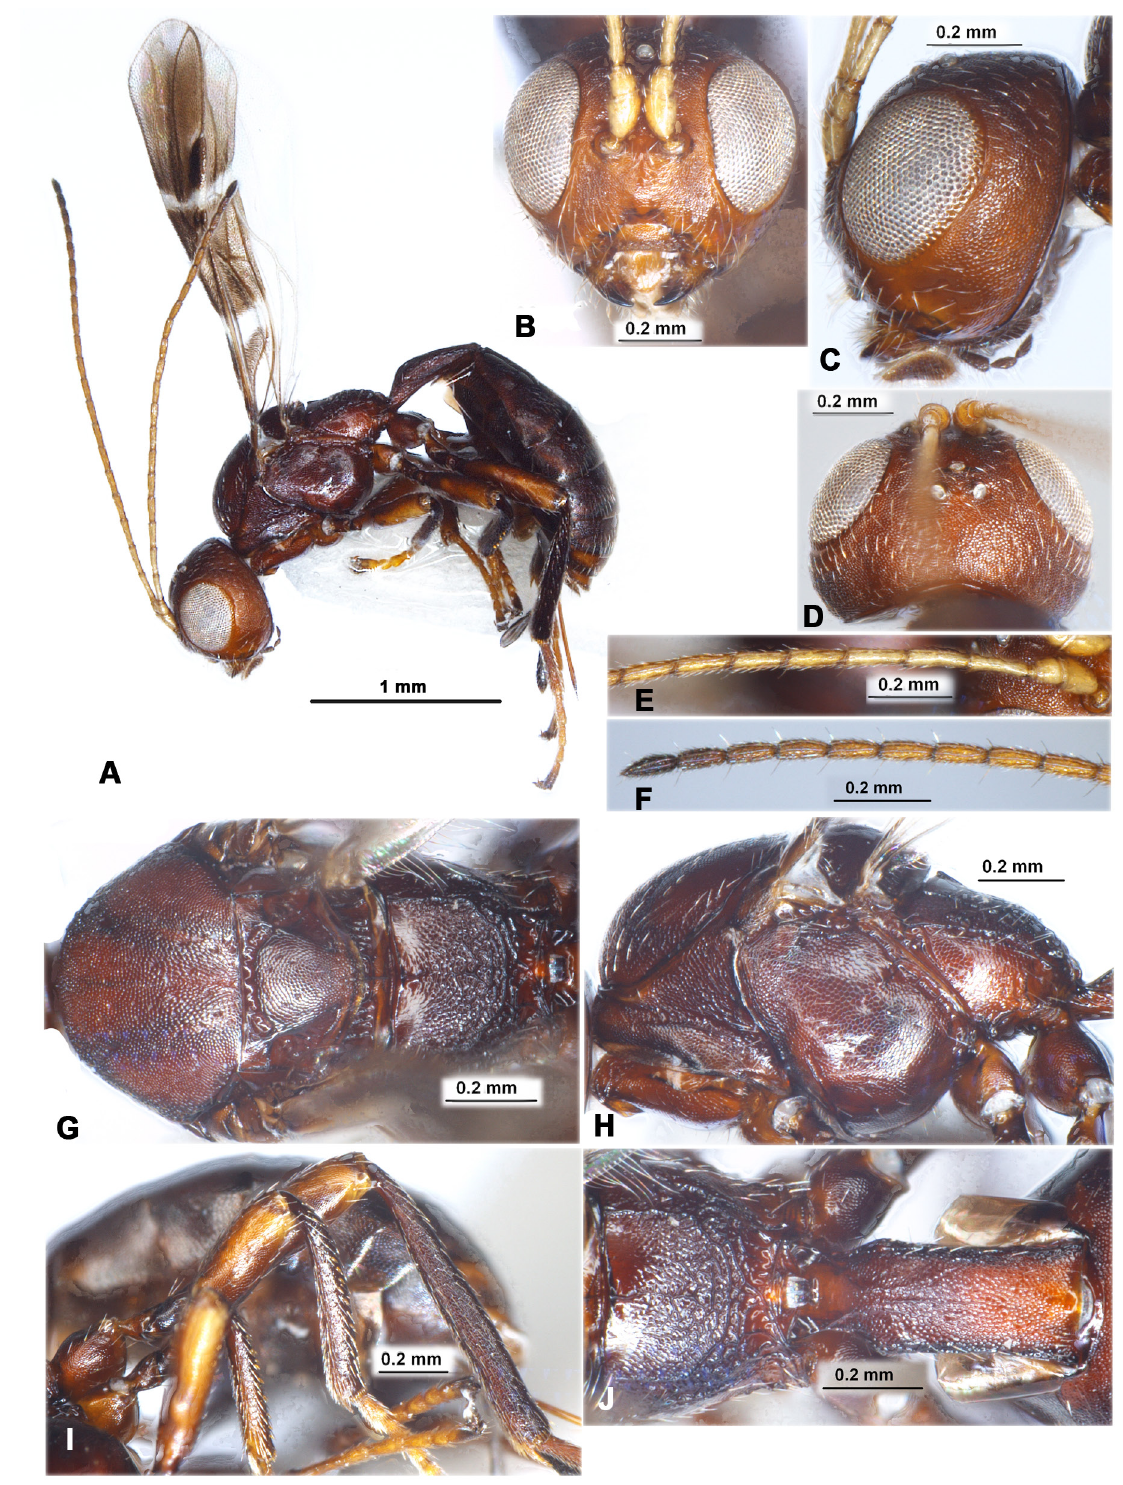
Fig. 20. Spathius lahji Belokobylskij sp. nov., holotype, ♀ (RMNH). A . Habitus, lateral view. B . Head, front view. C . Head, lateral view. D . Head, dorsal view. E . Basal segments of antenna. F . Apical segments of antenna. G . Mesosoma, dorsal view. H . Mesosoma, lateral view. I . Hind leg. J . Propodeum and petiole of metasoma, dorsal